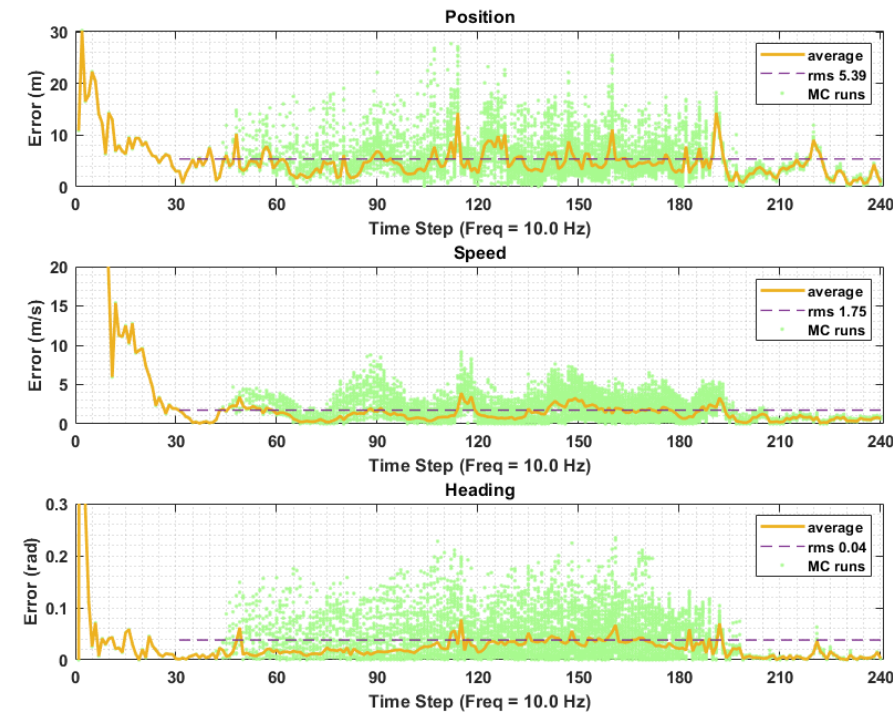
Figure 6. Average estimation